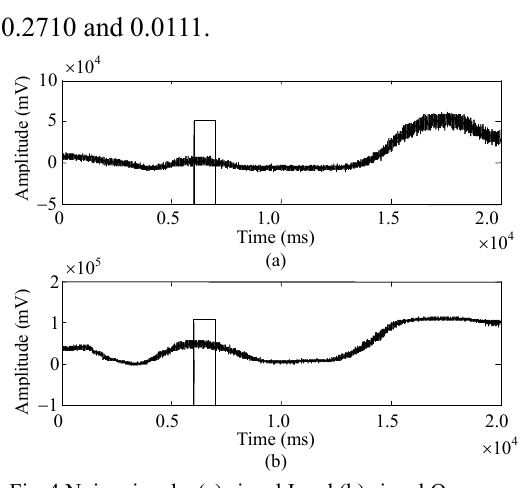
Fig. 4 Noise signals: (a) signal I and (b) signal Q.